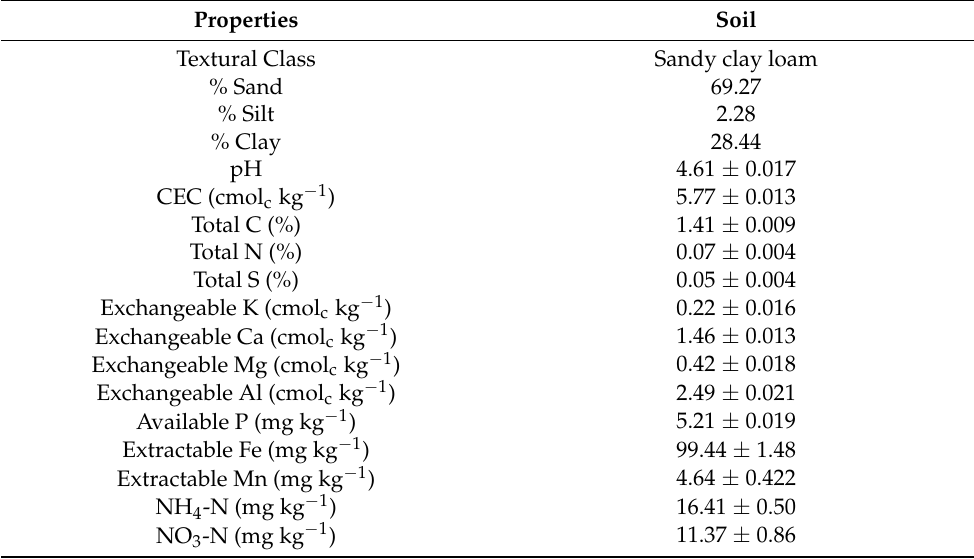
Table 1. Selected physical and chemical properties of experimental soil.